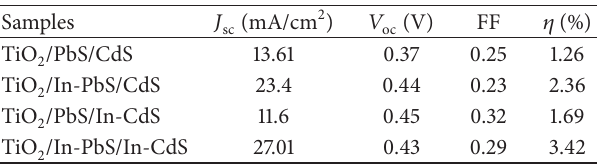
Table 1: Different photovoltaic parameter for different working